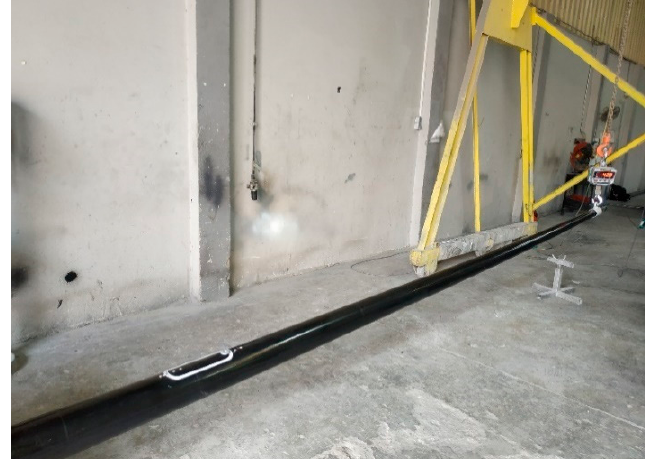
Figure 10. Pole test.